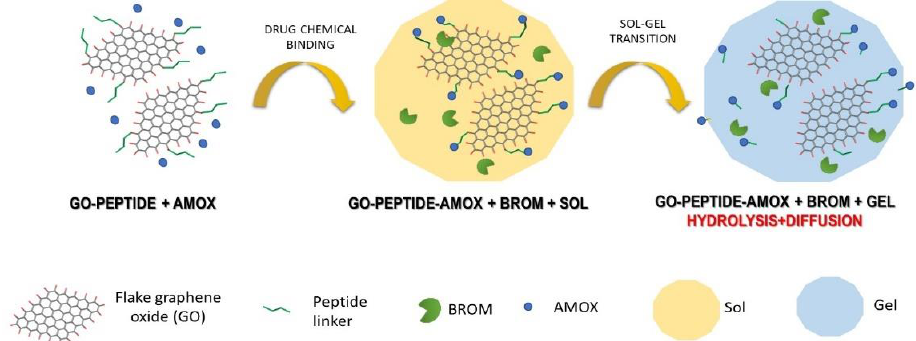
Figure 2. The scheme of preparing a drug carrier based on the covalent attachment of drug molecules and their enzymatic release and diffusion.